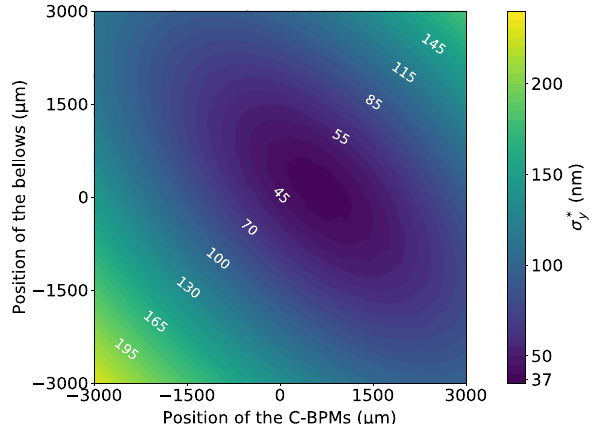
FIG. 14. Contour plot of the simulation of the impact of the position of the C-BPMs and the bellows on the average vertical beam size at the IP, σ (cid:1) y , for one machine and for a beam intensity of 1 . 0 × 10 10 e − .